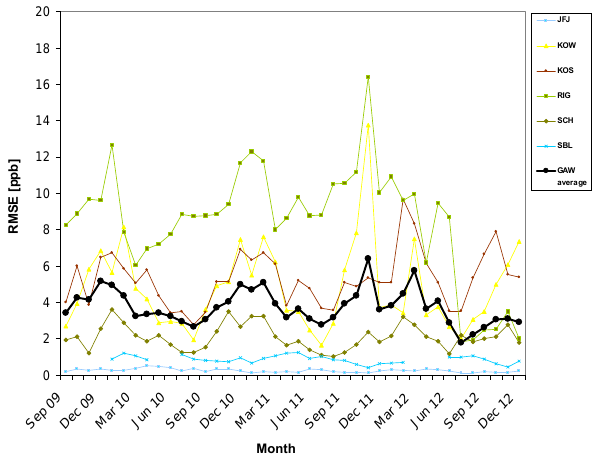
Figure 22. Root mean square error (RMSE) in ppb derived from the evaluation of the MACC_osuite with GAW NO 2 surface obser- vations over the period September 2009 to December 2012 (black line: global average of six GAW stations, multi-coloured lines: in- dividual station results; see legend to the right).